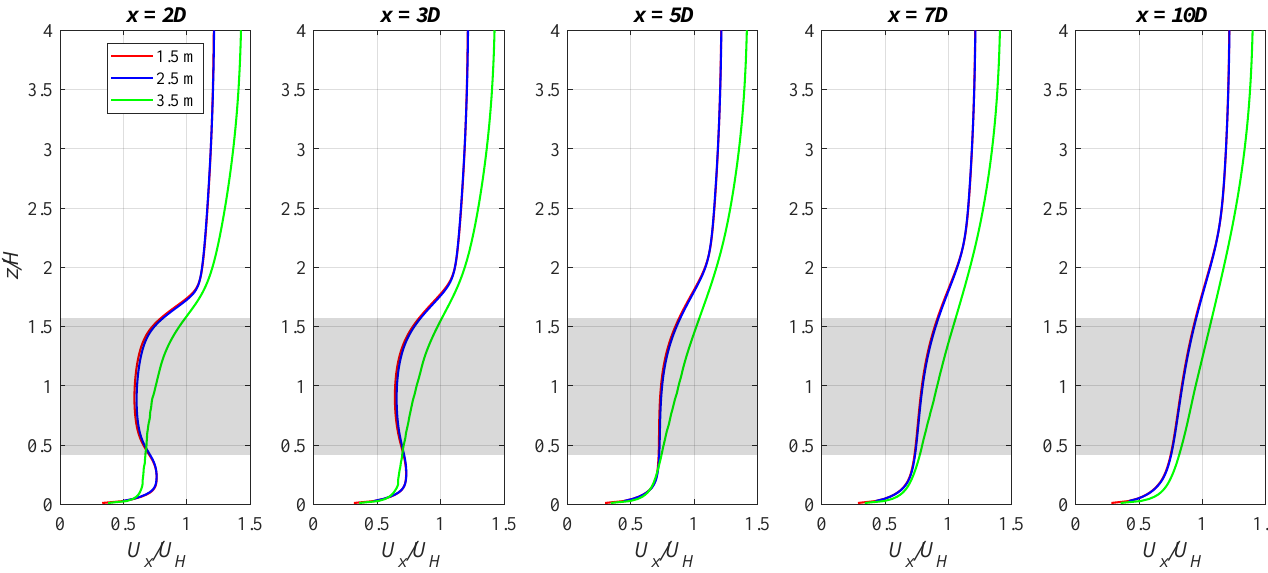
Figure 9. Vertical profiles of stream-wise velocity from the midplane for different mesh resolutions (the shaded region depicts the rotor area)